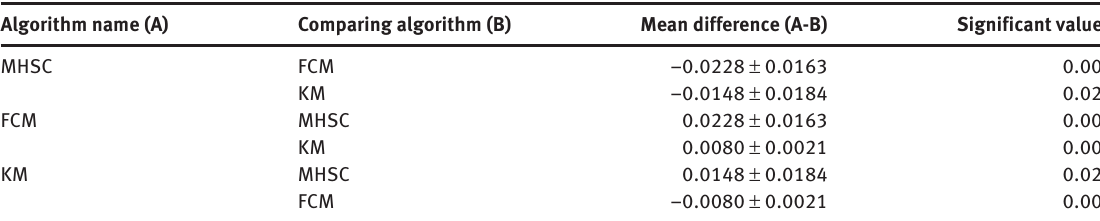
Table 9: Estimated Means and Pairwise Comparisons of Different Algorithms on the Minkowski Score Obtained by ANOVA Testing for the Cancer Dataset.